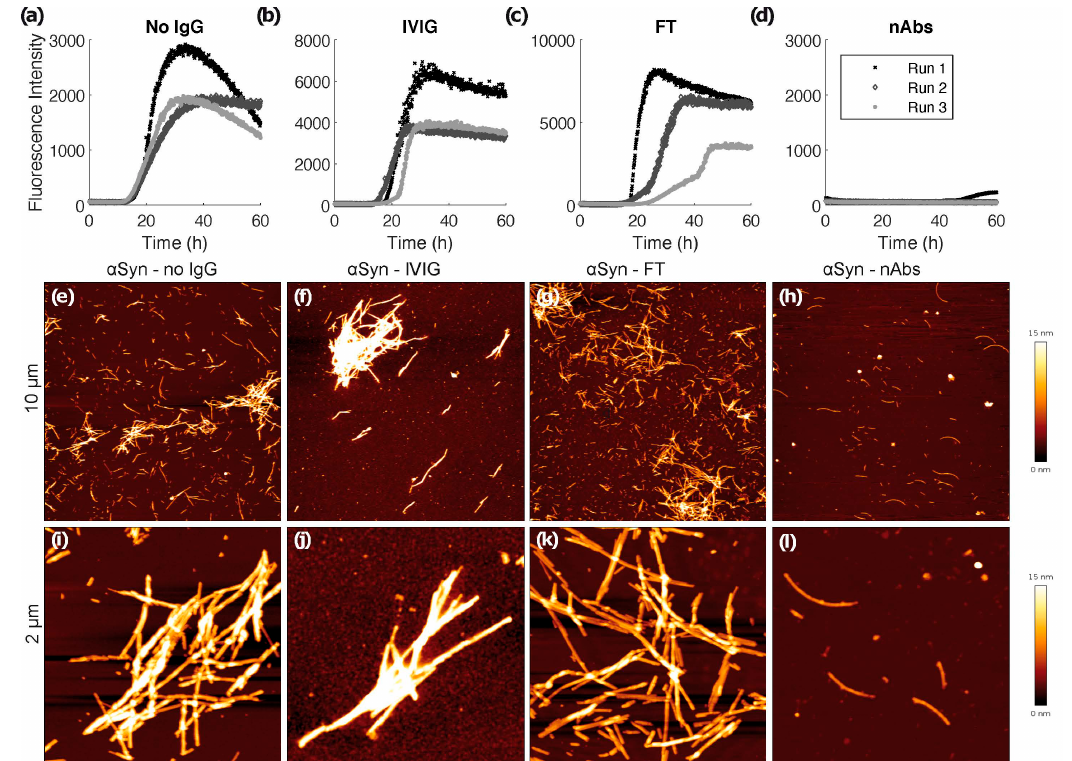
Figure 2. ThT fibrillation assay and atomic force microscopy. De novo fibrillation of 25 μ M α Syn in the absence ( a ) and presence of 0.1 μ M IVIG ( b ), FT ( c ) and nAbs- α Syn ( d ) followed by ThT fluorescence. Three replicates are shown per condition. At the end of the 60 h time course, samples were imaged via AFM ( e – l ). Representative overview images of the samples showing 10 × 10 μ m areas ( e – h ) and 2 × 22 μ M close-ups ( i – l ).